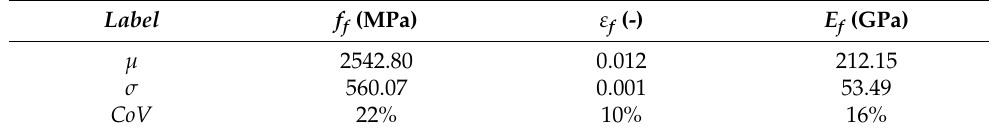
Table 1. CFRP tensile test results.